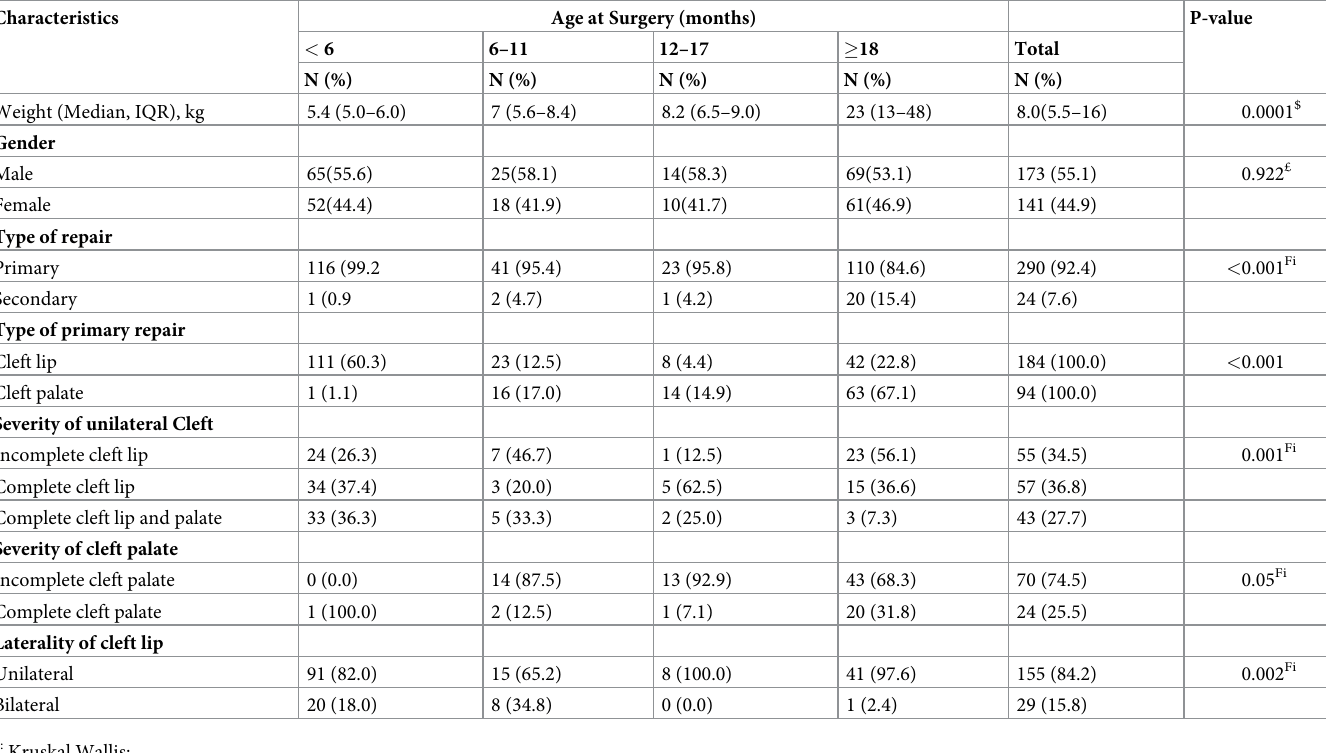
Table 3. Association of demographic and clinical parameters with age at primary